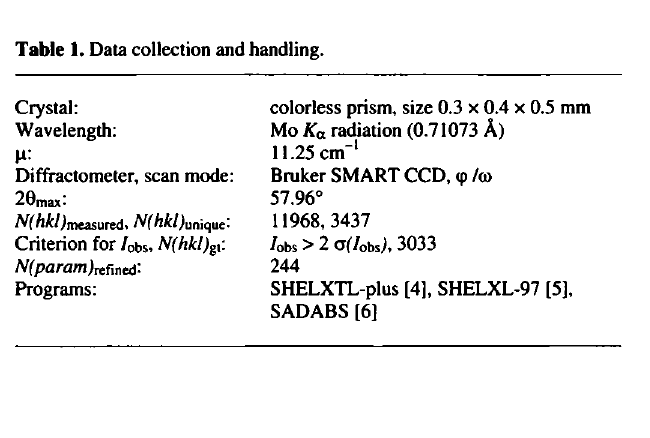
Table 1. Data collection and